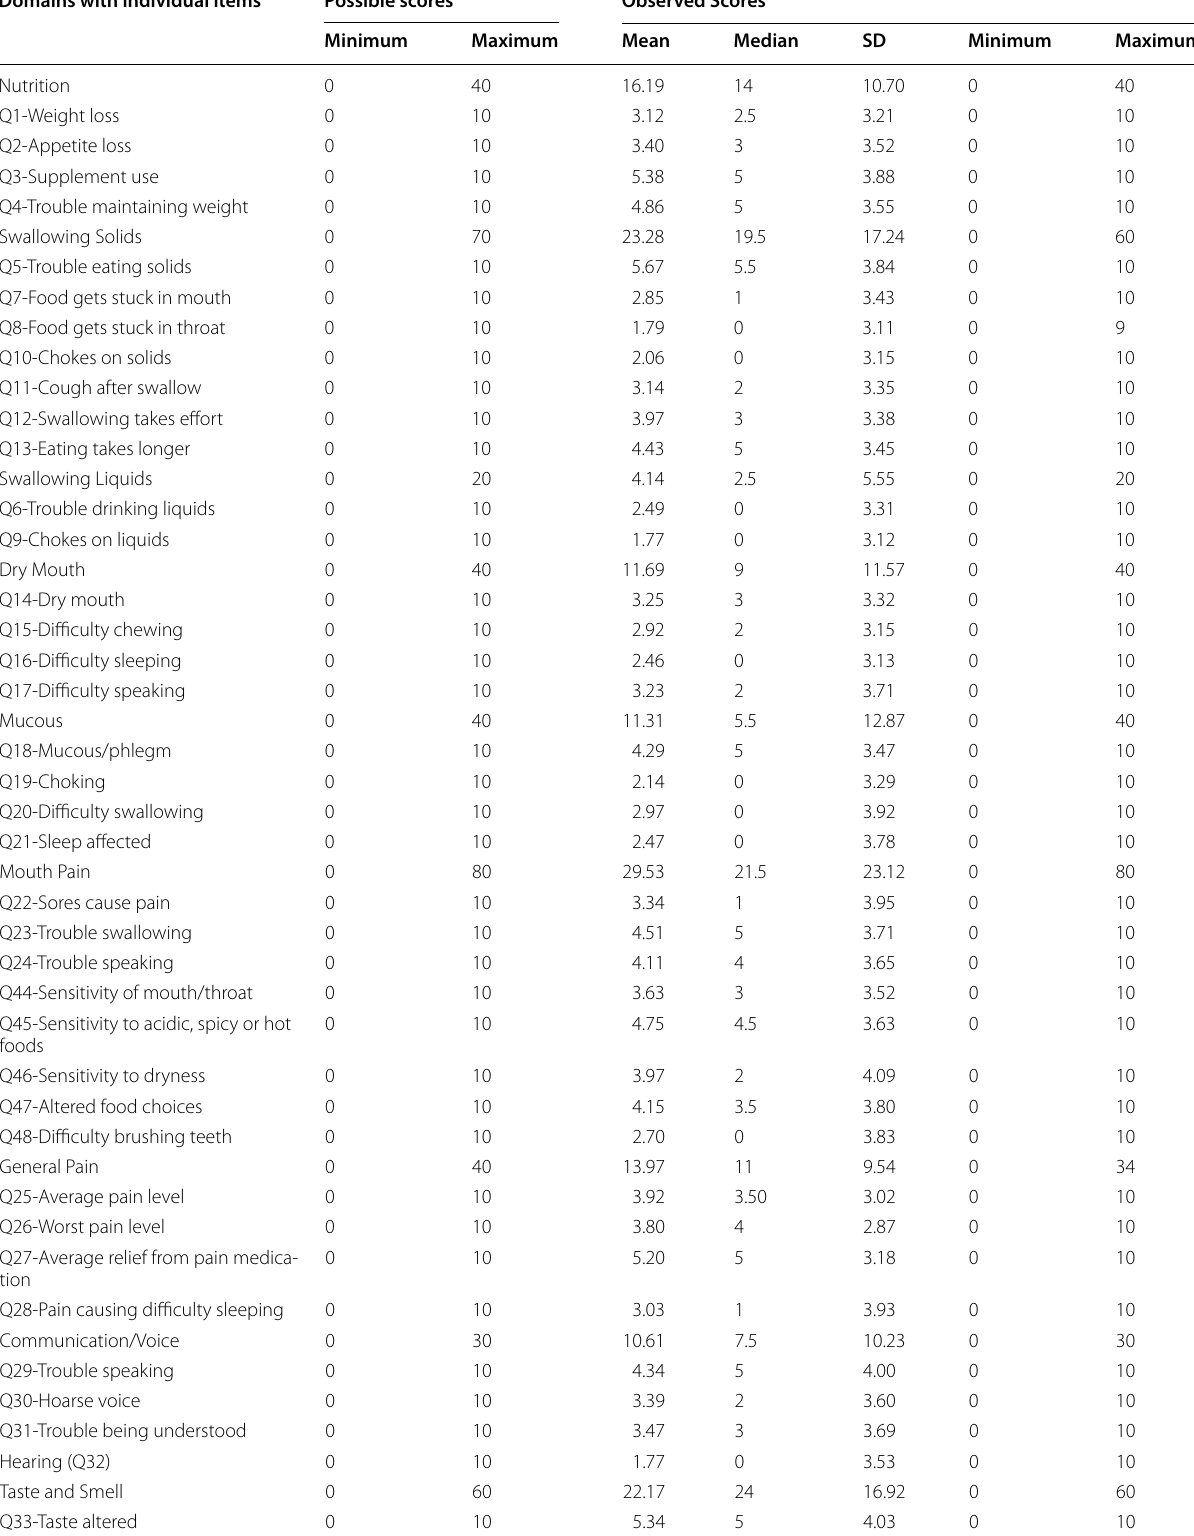
Table 3 Descriptive statistics of the VHNSS.2.0 Kannada